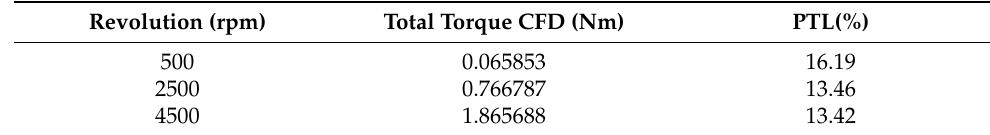
Figure 8. Bearing 6210—Torque losses in water and oil. Table 6. Results of the transient CFD simulations for the hub 61820 in oil if laminar flow is assumed. Revolution (rpm)